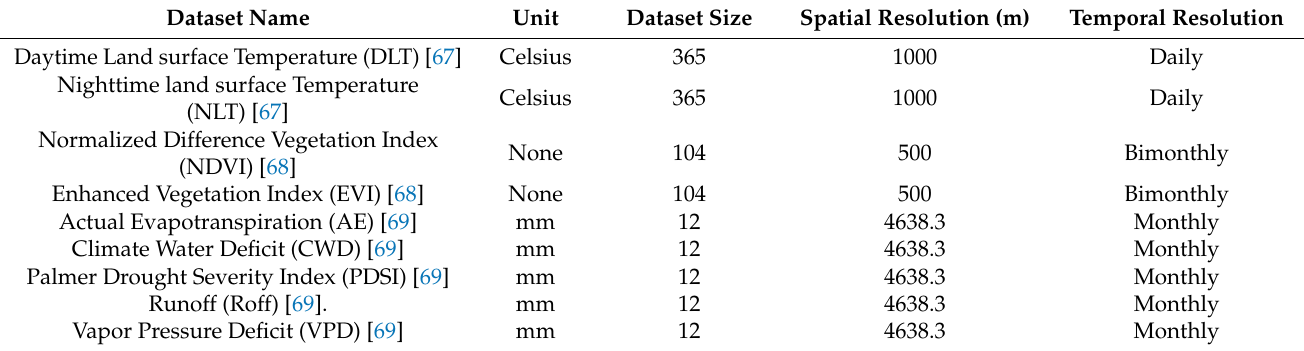
Table 1. Summary of the satellite imagery datasets used in this